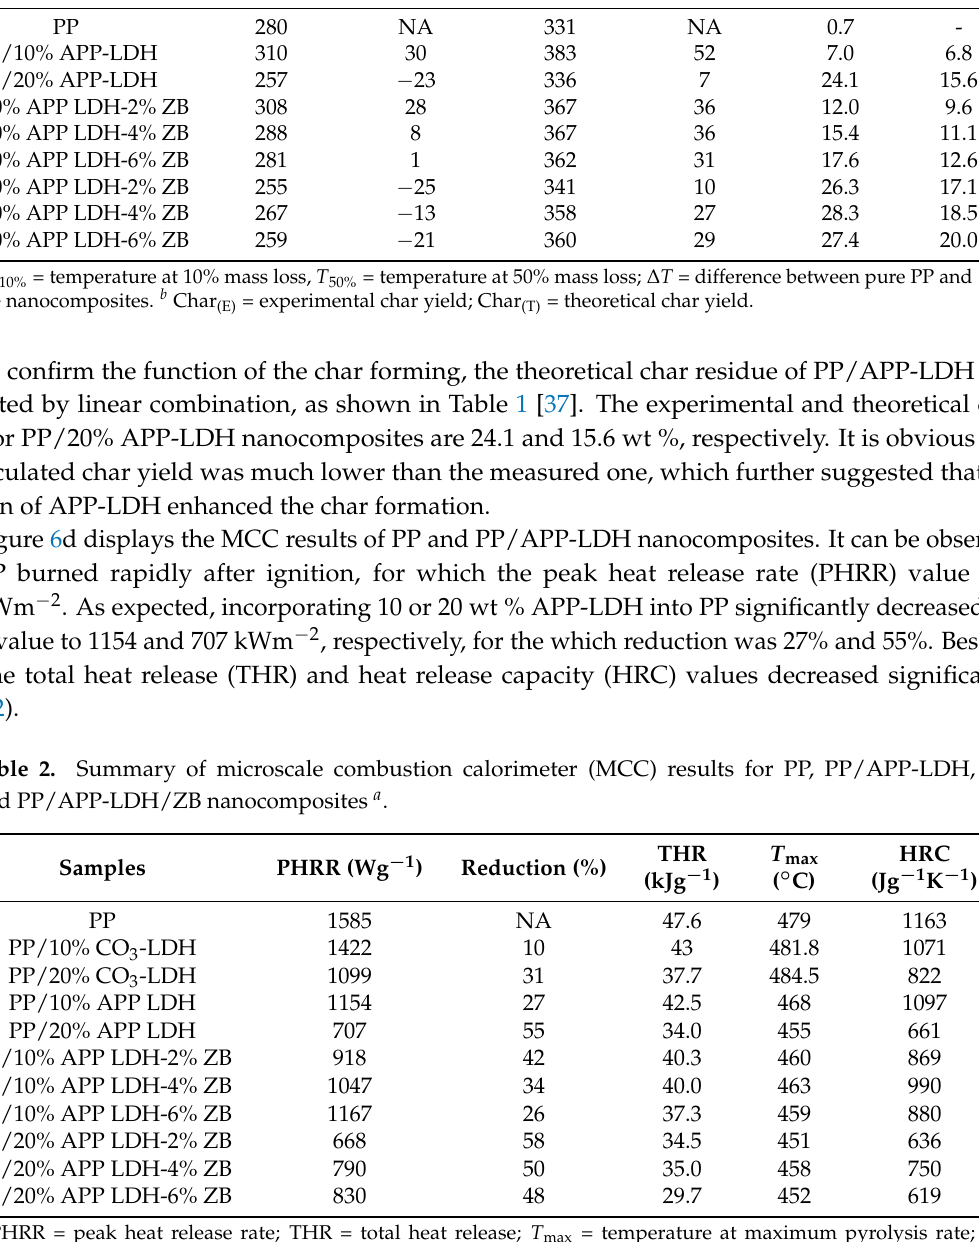
Table 1. Summary of TGA results for PP, PP/APP-LDH, and PP/APP-LDH/ZB nanocomposites a . Samples